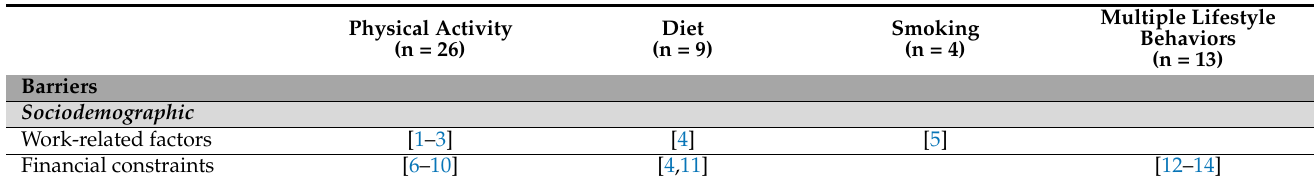
Table 3. Summary table of included qualitative studies on psychosocial determinants of lifestyle change in cancer survivors (n =